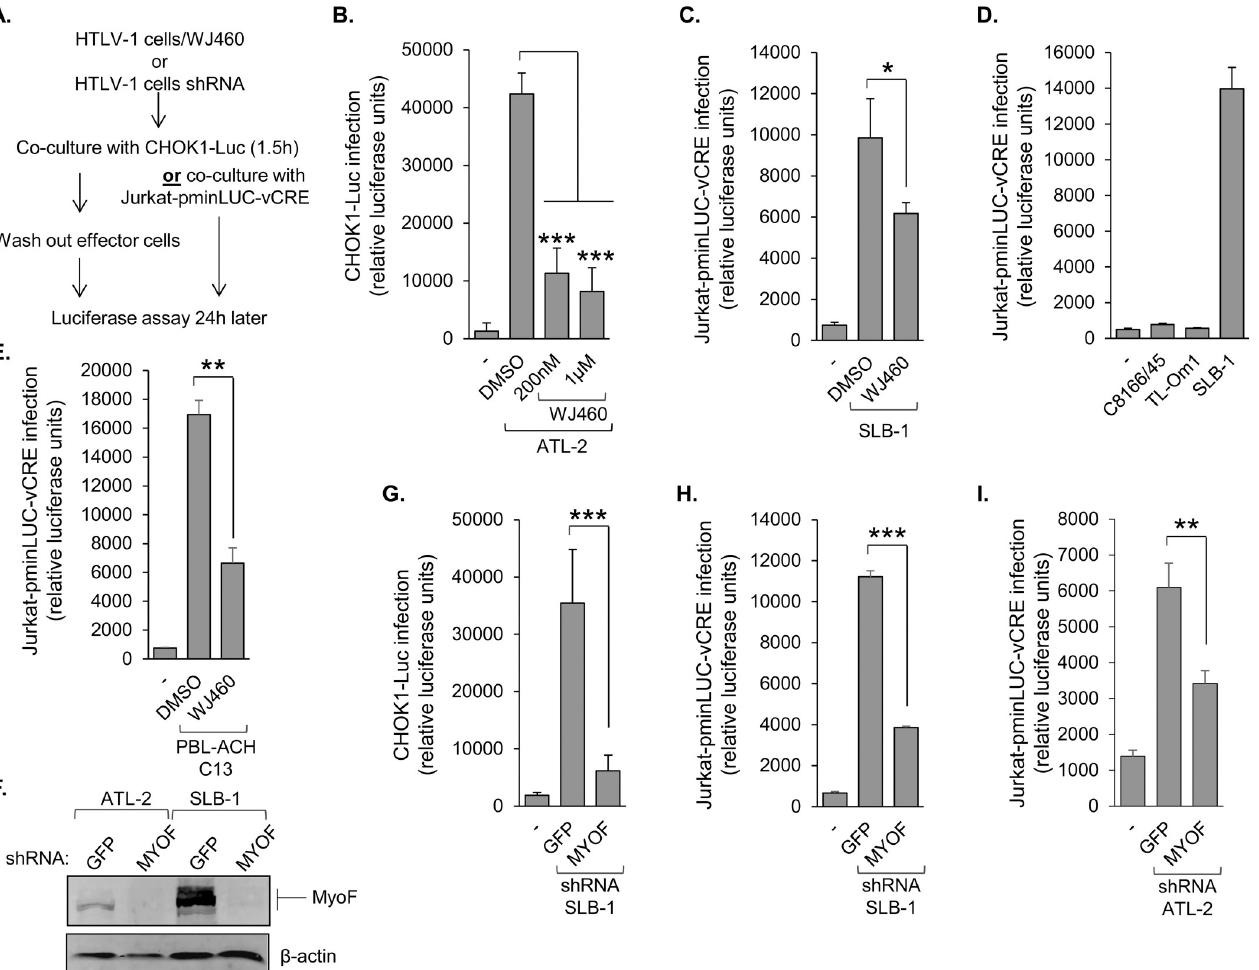
Fig 5. MyoF enhances HTLV-1 infection. (A) The flow diagram shows the co-culture/infection assay procedure using CHOK1-Luc or Jurkat-pminLUC- vCRE cells as target cells. (B) Inhibition of MyoF reduces HTLV-1 infection. ATL-2 cells were treated with DMSO or WJ460 (200nM or 1 μ M) prior to co- culture with CHOK1-Luc cells. (C) SLB-1 cells were treated with DMSO or 1 μ M WJ460 prior to co-culture with Jurkat-pminLUC-vCRE cells. (D) C8166/45 and SLB-1 cells (both high Tax expression) and TL-Om1 cells (no Tax expression) were co-cultured with Jurkat-pminLUC-vCRE cells. (E) An HTLV- 1-immortalized primary human T-cell clone (C13) was treated with DMSO or 1 μ M WJ460 prior to co-culture with Jurkat-pminLUC-vCRE cells. Graphs (B), (C) and (D) show luciferase assay results averaged from at least three replicates for each condition of a single experiment and are representative of three independent experiments; � p < 0.05, ��� p < 0.001. Graph (E) shows luciferase assay results average from three replicates for each condition of a single experiment and is representative of two independent experiments; �� p < 0.01. (F) Knockdown of MyoF expression reduces HTLV-1 infection. MyoF expression in control (GFP) and MyoF knockdown ATL-2 and SLB-1 cells. Whole cell extracts (50 μ g) were analyzed by Western blot using antibodies against MyoF and β -actin. (G) SLB-1 cells stably expressing an shRNA targeting GFP (negative control) or MYOF mRNA were co-cultured with CHOK1-Luc cells.